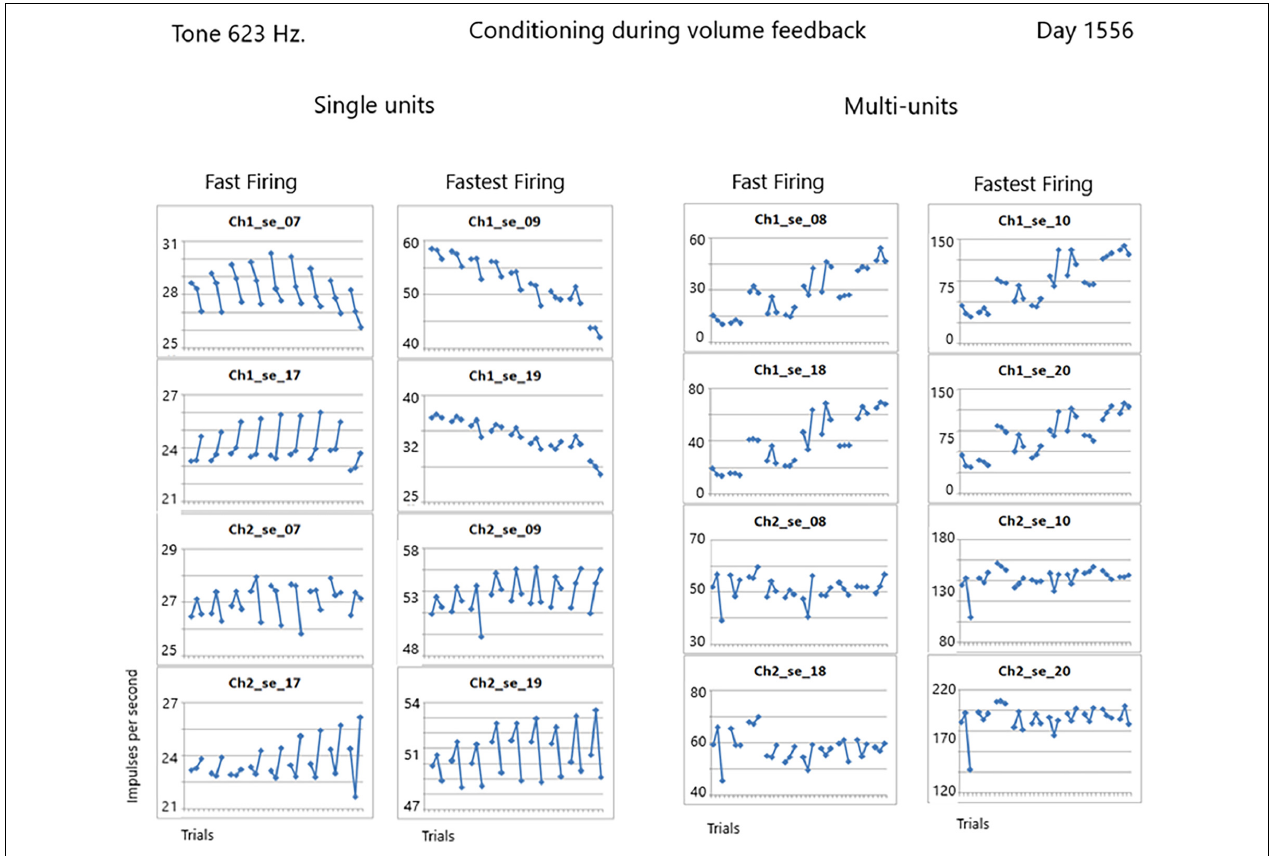
FIGURE 10 | Comparison of single unit and multi-unit firing rates during conditioning with volume feedback recorded on day 1556 after